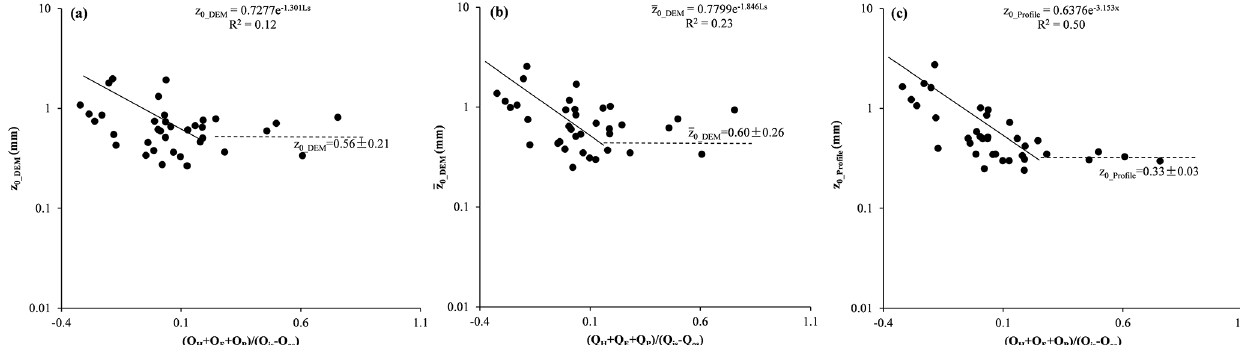
Figure 12. Aerodynamic surface roughness vs. L S . Where L S = (Q H + Q E + Q P )/(Q is − Q os ), in (a) z 0_DEM was estimated based on DEM-based prevailing upwind direction, in (b) z 0_DEM was the average of the four cardinal wind directions’ z 0 in order to represent overall aerodynamic surface roughness and in (c) z 0_profile was the average of two orthogonal directions z 0